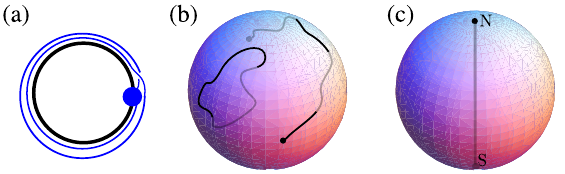
FIG. 4. (a) The SO ð 2 Þ order-parameter space and a vortex of winding number 2. (b) The SO ð 3 Þ order-parameter space and the two types of topologically distinct loops: a trivial loop and a vortex. The loops can lie on the surface of (black) or inside (gray) the solid sphere. The loops corresponding to a vortex connect two antipodal points on the surface of the sphere. (c) The nontrivial loop corresponding to the vortices shown in Figs. 1(c) and